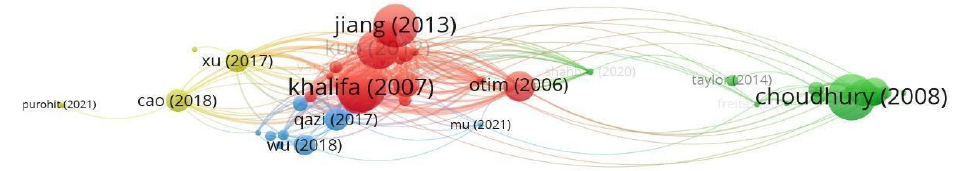
Figure 8. Bibliographic coupling networks. [49–51,61,62,67,74,76,83,86,87,89,95,97] Cluster 1, represented by the color red in the graph, demonstrates that the authors